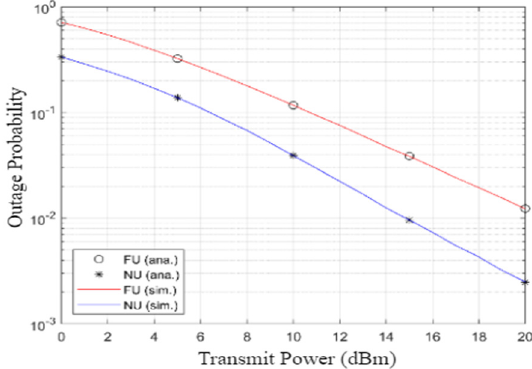
Figure 5. OP vs. Transmit Power.